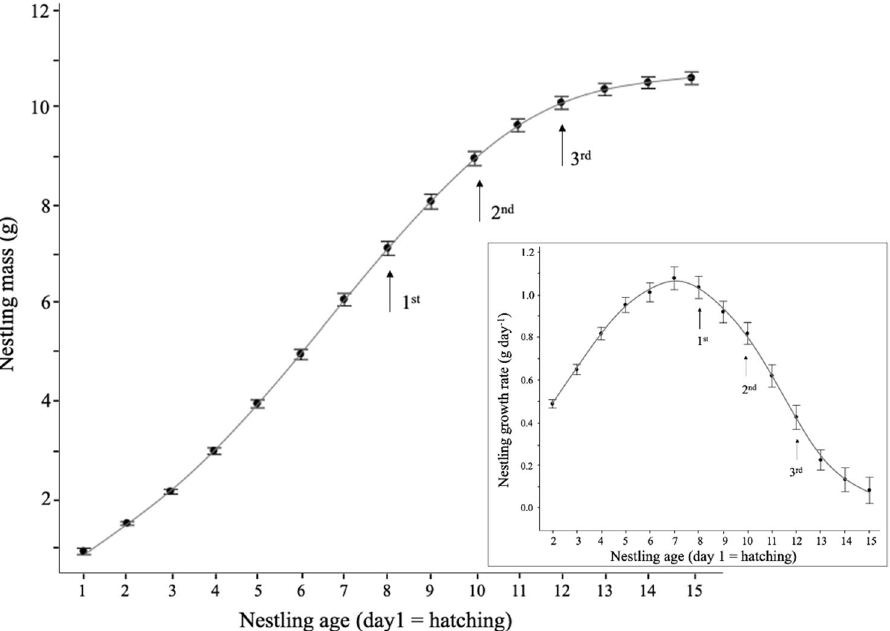
Figure 1. Growth curve showing nestling mean daily mass according to age in days since hatching in black- capped chickadees and boreal chickadees sampled at the FER Macpès, Rimouski, Canada. This figure shows both species combined (see text). The three arrows show the days of stomach contents sampling. Insert shows daily growth rate (calculated over the last 24 h) according to nestling age. We used data from 858 nestlings from 173 broods. Of those, 98 broods were black-capped chickadees and 75 broods were boreal chickadees. Data are mean ± 95% confidence